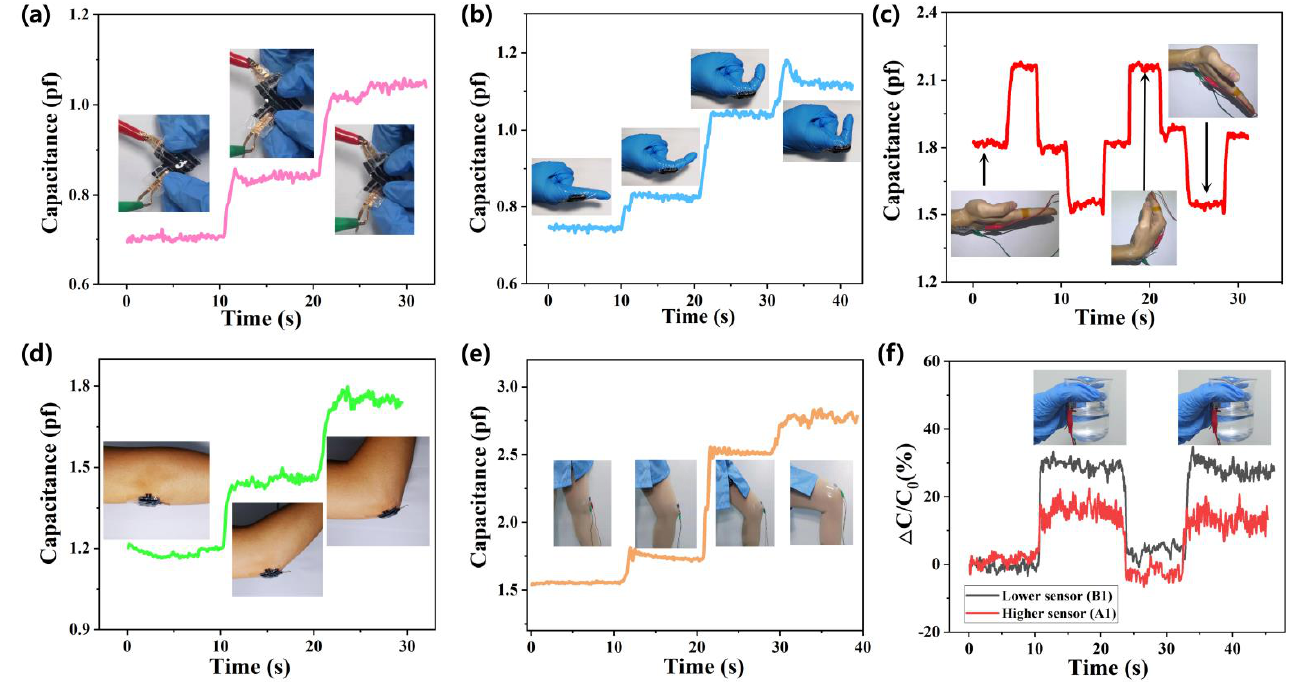
Figure 6. Experimental results of various mechanical stimulate stresses which were extracted from human body testing. ( a ) Capacitance change curves of flexible pressure sensors with different tortuosity (without torture, around 45°torture, and 90°, respectively). ( b – e ) The capacitance curves of the joints as the finger, wrist, elbow, and knee with the change of bending degree are pasted on the device. As the flexion of the joints varies, the signal shows different strengths. ( f ) Paste on the outside of the cup to detect the signal changed curves. The pink line stands for the lower electrode which changed more acutely and the purple line is the upper electrode with less variation.